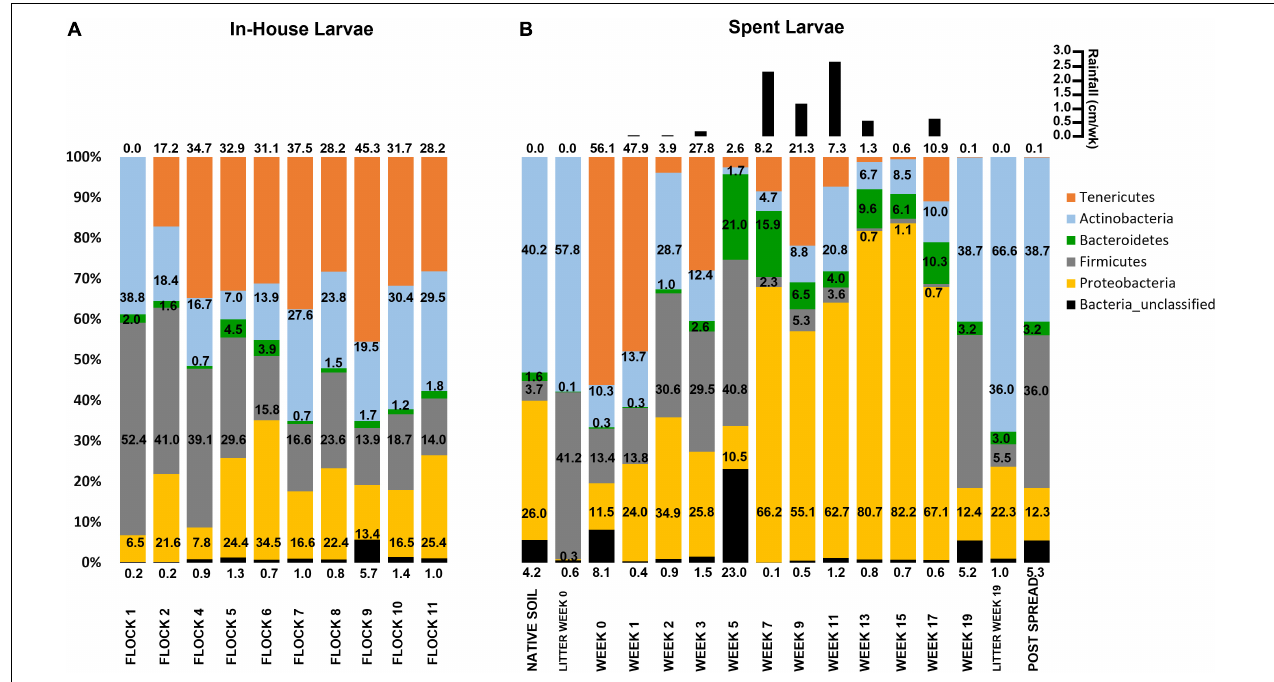
FIGURE 1 | Histograms showing the mean relative abundances of bacterial phyla associated with (A) In-House Larvae samples taken during successive flock rotations (1 through 11), and (B) Spent Larvae taken after deposition of the spent litter into pastureland, including pastureland soil prior to deposition of the spent litter (Native Soil), samples of the spent litter at the time of deposition onto the pastureland (Litter Week 0) and just prior to spreading (Litter Week 19); the soil/litter combination after spreading onto the pastureland (Post Spread); and the larvae collected from that litter over the 19 weeks of stockpiling (Week 0 through Week 19). The values correspond to the percentage of total sequences of that taxon for that sample. In the upper right-hand corner is weekly total rainfall (cm/week) for Weeks 1–3 and Post Spread and bi-weekly total rainfall for Weeks 3–19 at the site until the litter was spread on the field.